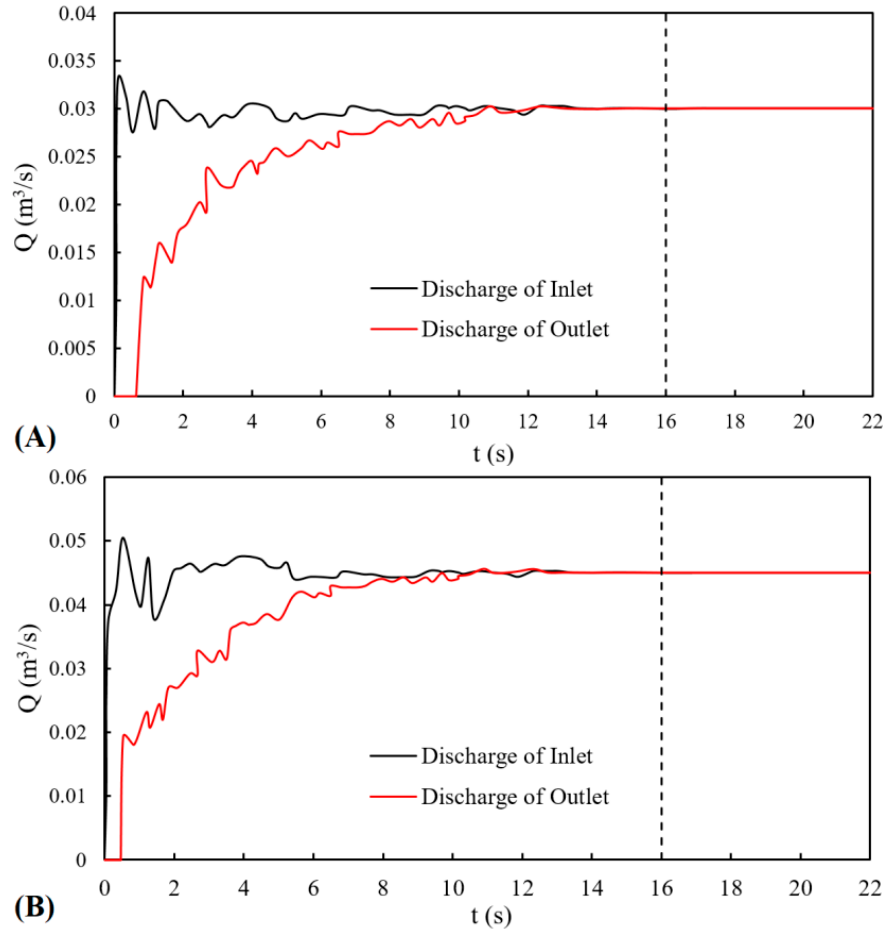
Figure 5. Time changes of the flow discharge in the inlet and outlet boundaries conditions ( A ): Q = ( A ): Q = 0.03 m 3 /s ( B ): Q = 0.045 m 3 0.03 m 3 /s ( B ): Q = 0.045 m 3 /s.